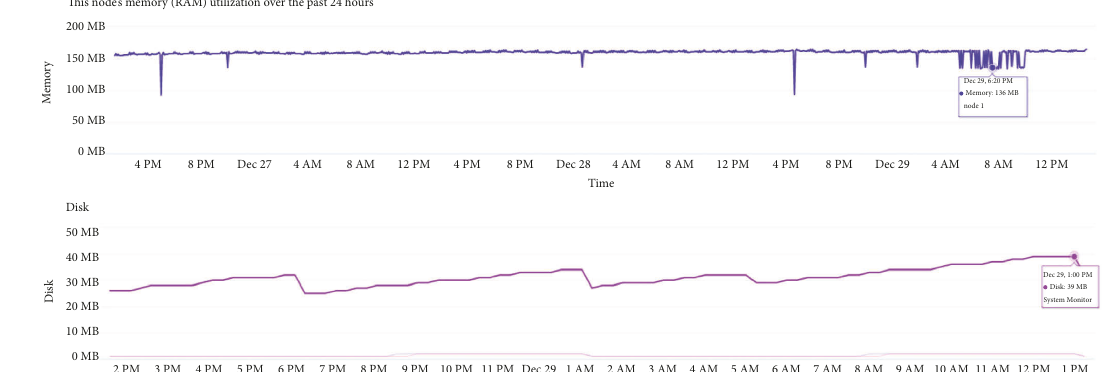
Figure 11: The minor impact of the smart contract script on the machine resources.